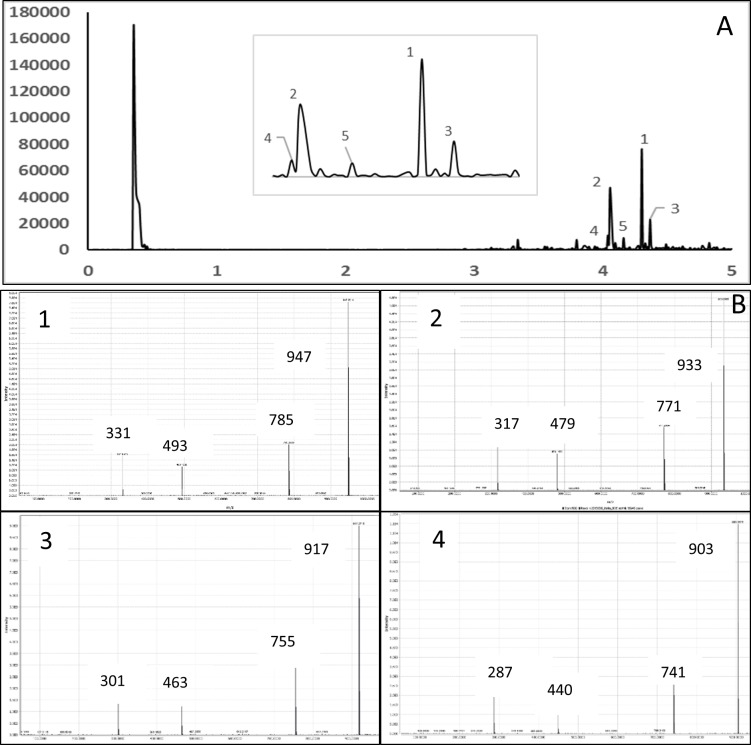
Total ion chromatogram (TIC) of F2 fraction from CO97216-1P/P tubers in ESI + ve mode (A). Inset: enlarged chromatogram of the selected area.MS/MS spectra of each peak (B).